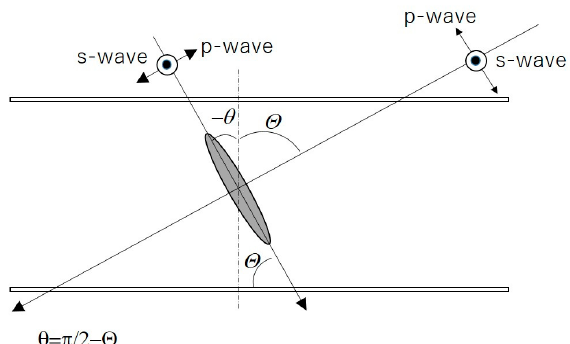
Figure 3. Light passing through the HAN or high pretilt angle LCDs from the incident angles of Θ and − θ. In contrast, the vibration of the s-wave is perpendicular to the molecular axis and the absorption is small. For the incident light from the direction of − θ , both the p- and s-waves vibrate perpendicularly to the molecular axis of the dye, resulting in the absorption being small. The transmittance, even from the Θ direction, is not sufficiently reduced owing to the presence of the s-wave. The optical device shown in Figure 4 was proposed to realize a large ratio of the light strength from the Θ and − θ directions. By utilizing this device, it is possible to realize the ratio between the largest light strength from the − θ direction and the smallest one from the Θ direction. Figure 4. Structure of two-layer optically anisotropic LC filters. Figure 5 shows the mechanism which causes the incident angle dependence of the transmittance. In the case of incident light to LCD1 from the Θ direction, the absorption of the p-wave is large, and the one of s-wave is small. By passing through the half-wave plate, the s-wave changes into a p-wave, which is effectively absorbed by passing through LCD2. However, in the case of incident light from the − θ direction, both p- and s-waves vibrate perpendicular to the dye molecular axis, passing through both LCD1 and LCD2 without large absorption. Therefore, the transmittance from the Θ direction becomes low and that from the θ direction becomes high. The device shown in Figure 4 would realize the largest ratio between the large light strength from the Θ direction and the smallest one from the − θ direction.